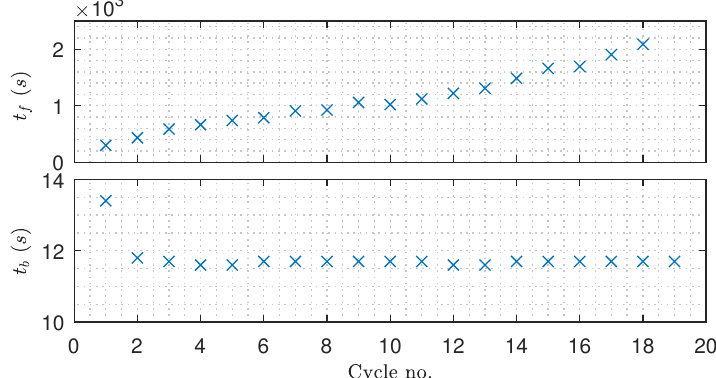
Figure 16. The filtration and backwashing durations from the experimental validation of the proposed algorithm—based on data from Figure